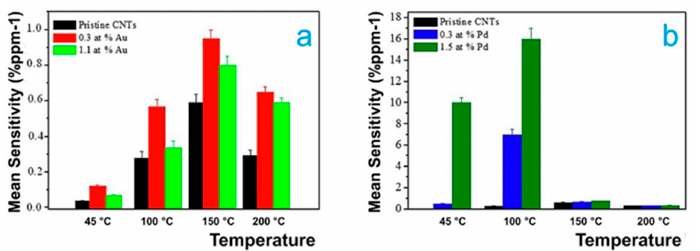
Figure 6. Mean sensitivity of pristine and ( a ) Au- and ( b ) Pd-modified MWCNTs-based sensors toward NO 2 gas at different sensor operating temperatures in the range 45–200 °C [38]. Table 1 summarizes the different nanoparticles supported on CNTs that have been used for the sensing of NO 2 gases. An analysis of sensing properties presented in this table indicates that the lower detection limit is 0.003 ppm detected by the Pt-SWCNTs system operating at 200 °C [87], while at RT, the detection limit is 0.088 ppm using ZnO-SWCNTs [98]. Table 1 also indicates that the Ag-SWCNTs sensor has the lowest time response of 8 s compared with other systems [95]. All these results demonstrate that decorated CNTs with metal nanoparticles can enhance the response sensor due the metal nanoparticles. Thus, the role of metal nanoparticles on CNTs is to accelerate the surface reaction, increase active sites for the adsorption of gas molecules, and improve the electrical properties, which in turn increase the sensitivity to small gas molecules. Table 1. Summary of NO 2 gas sensors based on CNTs decorated with nanoparticles. Sensor Type